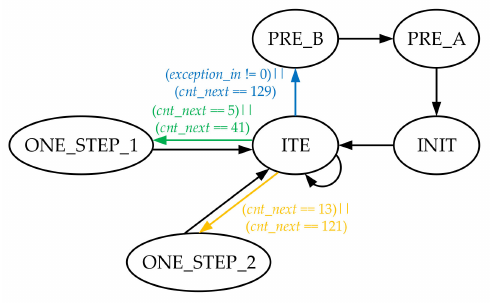
Figure 4. State transition diagram of finite state